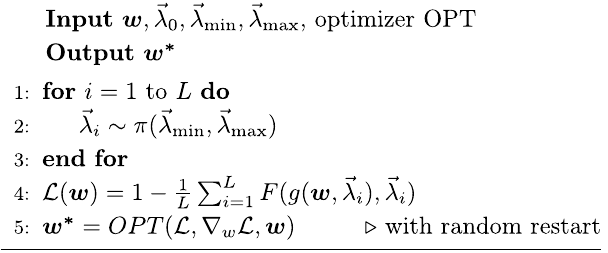
Algorithm 2. SOMA BP.